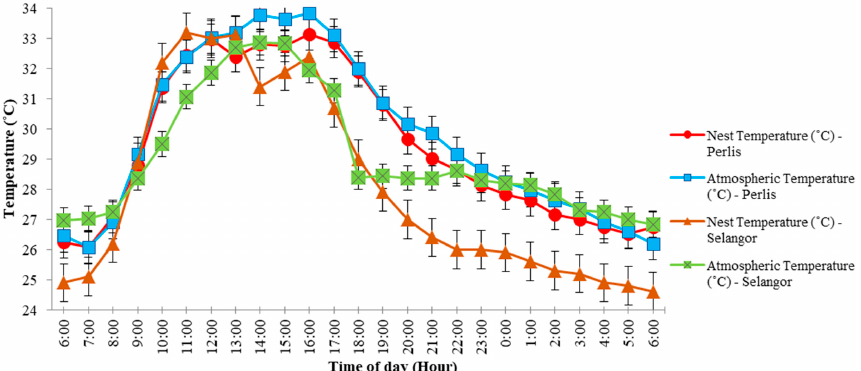
◦ C) and atmospheric temperature ( ◦ C)